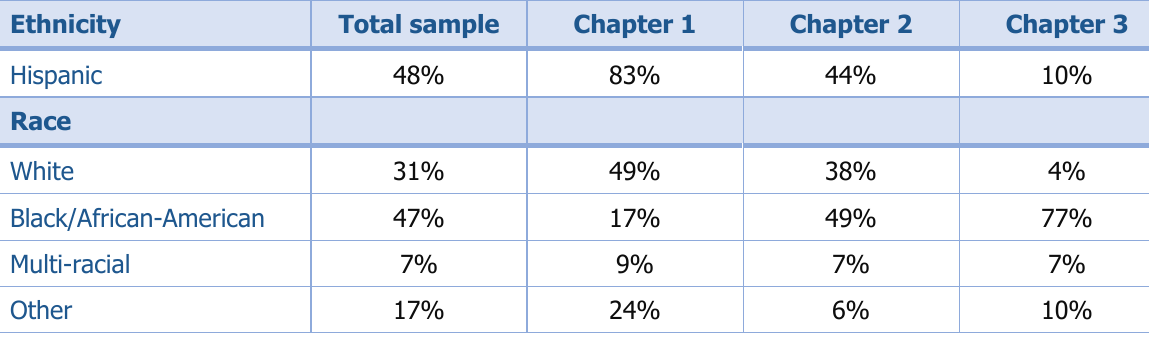
Table 1. Race, Ethnicity Distribution by MMP Chapter